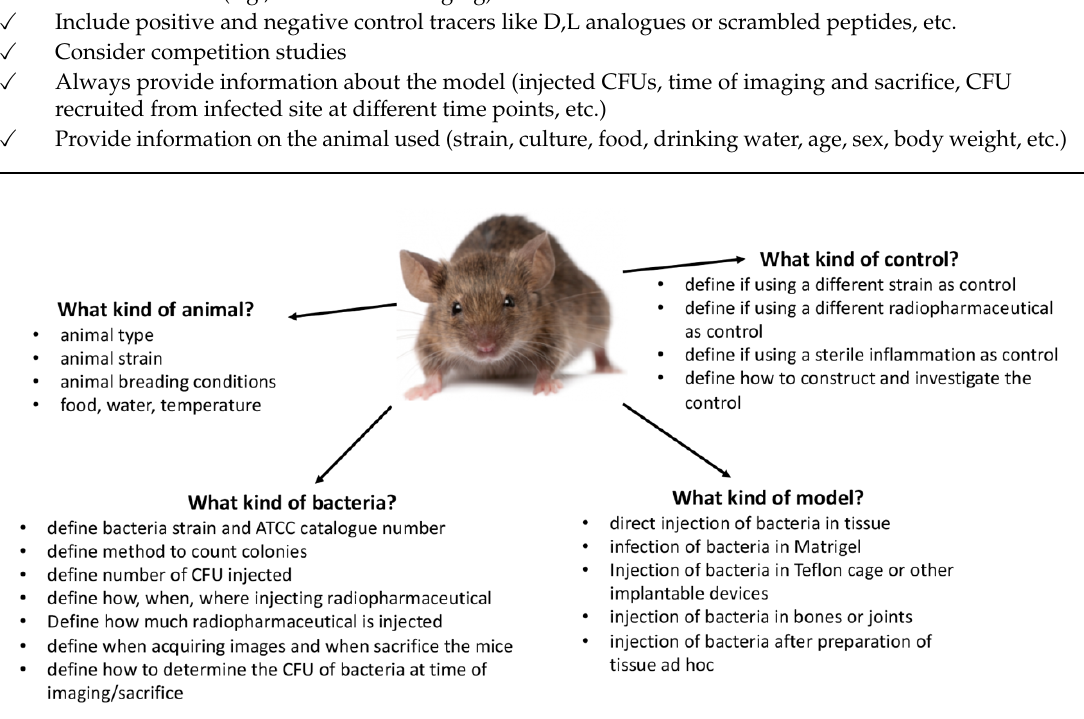
Figure 2. Schematic representation of the most relevant aspects to be taken in consideration when planning new experiments in animal models for targeting bacteria.